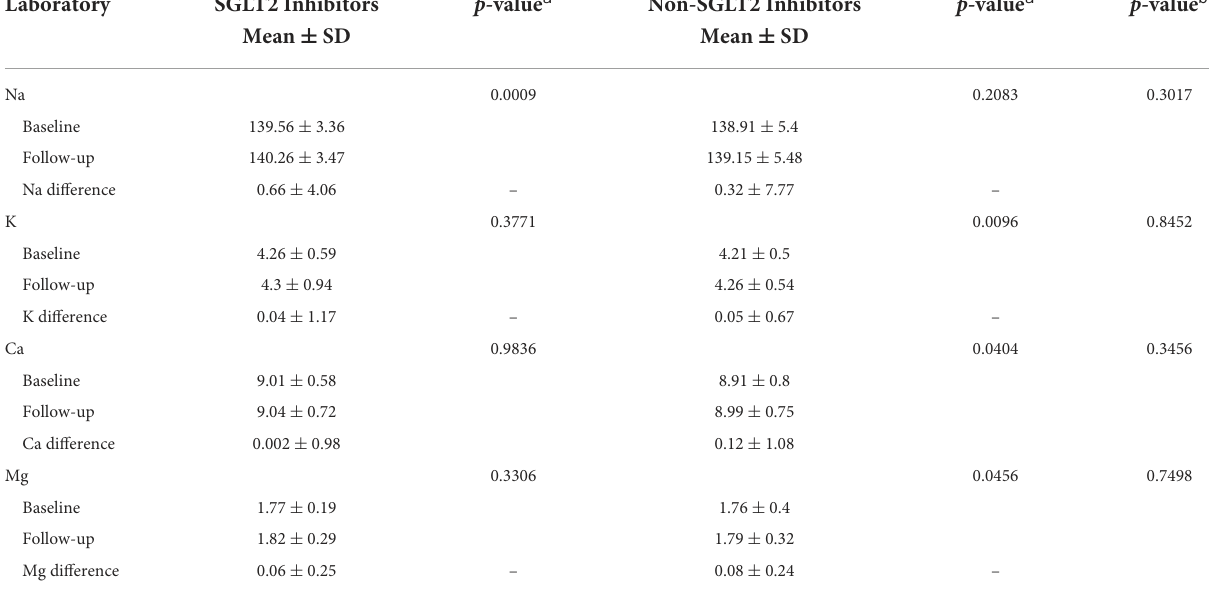
TABLE 5 Electrolyte outcomes of study